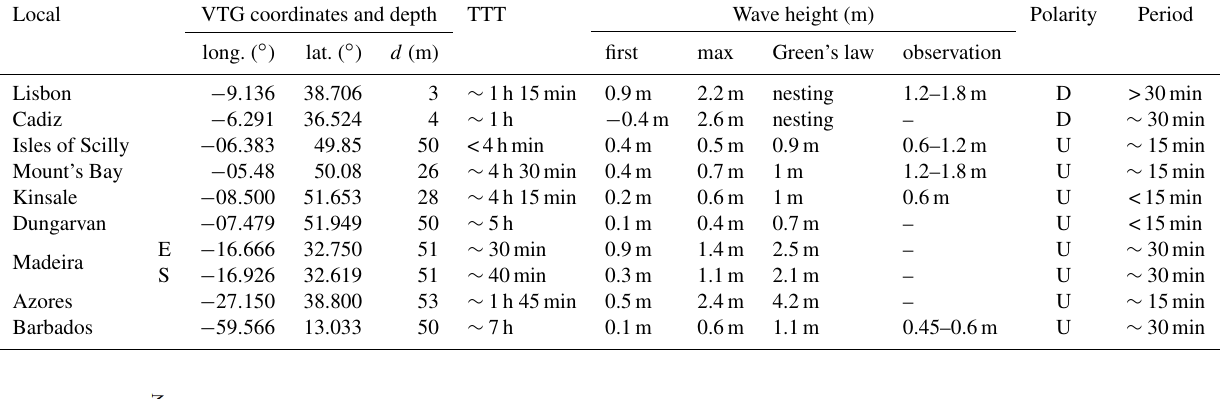
Table 4. Results of the VTGs for hypothesis B. The column TTT lists the observed tsunami travel times. The column polarity indicates the first movement of the sea upward (U) or downward (D).